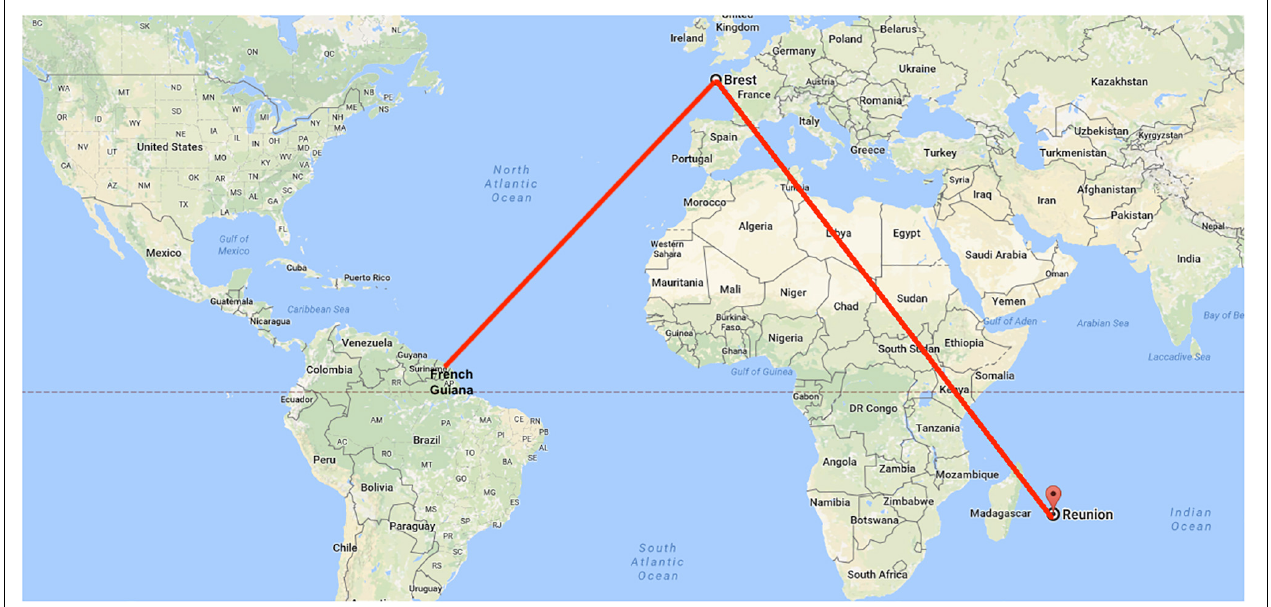
FIGURE 1 | Geographical locations of Reunion Island, French Guiana and Brest.